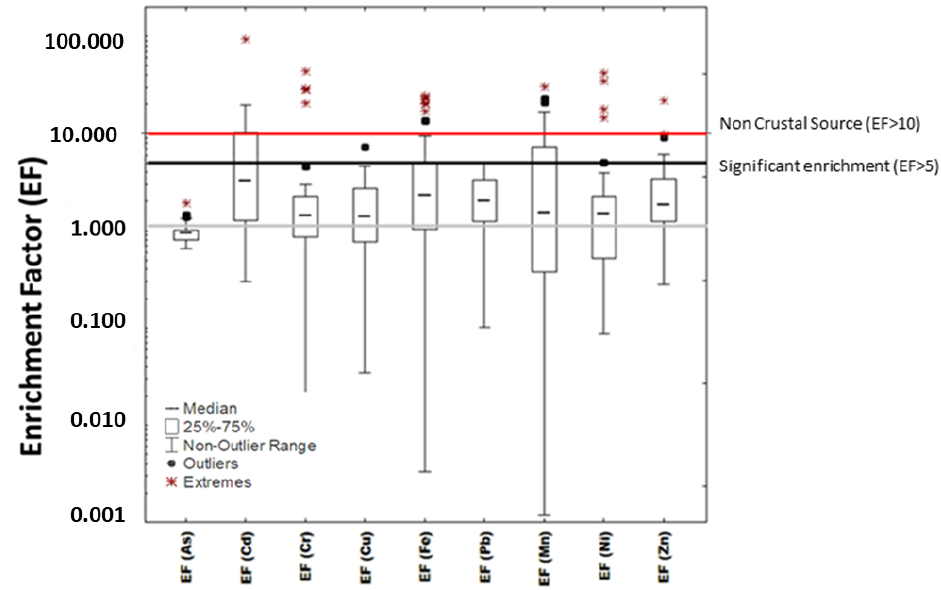
Figure 5. Box plot of the Enrichment Factor values for metals analyzed in the Conceição River basin. The red line highlights EF values greater than 10, interpreted as a non-crustal source [46,54,55].